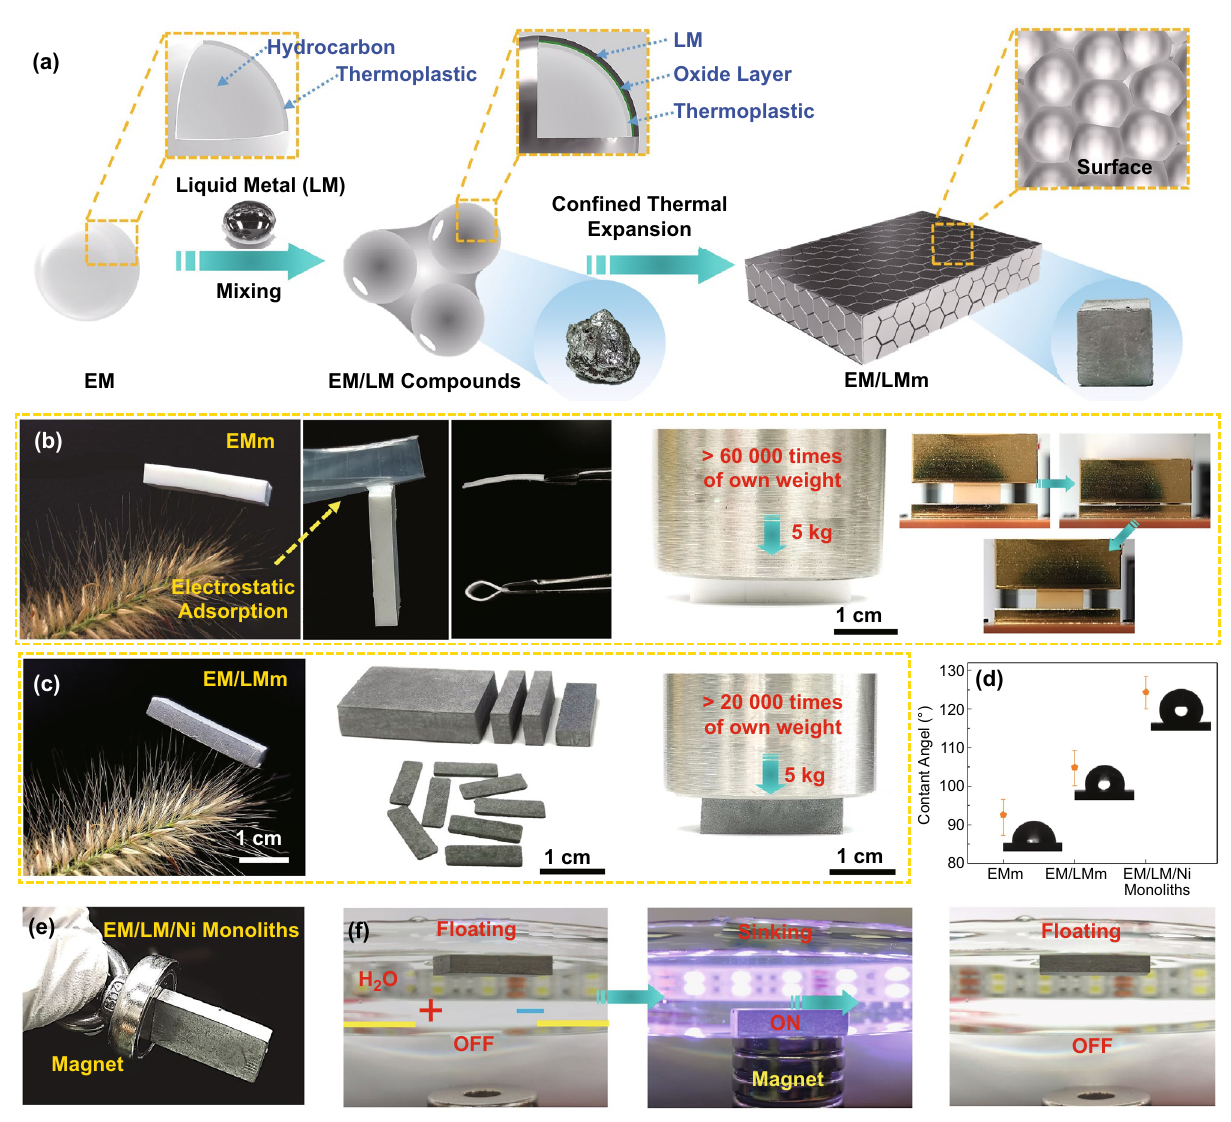
Fig. 1 Schematic of EM/LMm preparation and macroscopic features demonstration. a Illustration of the fabrication process of EM/LMm and forming mechanism. b , c Optical photographs of pure EMm and EM/LMm show low density, super elastic, tailorability, and high load‑carrying ability. d The contact angle of different monoliths. e , f The demonstration of EM/LM/Ni monoliths as underwater magnetic‑controllable